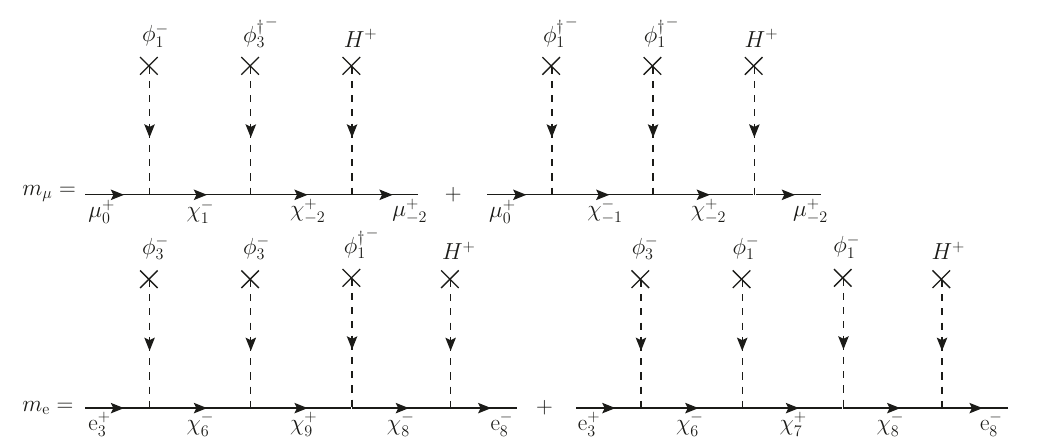
Table 1 . Fields and their (cid:13)avor symmetry assignments.